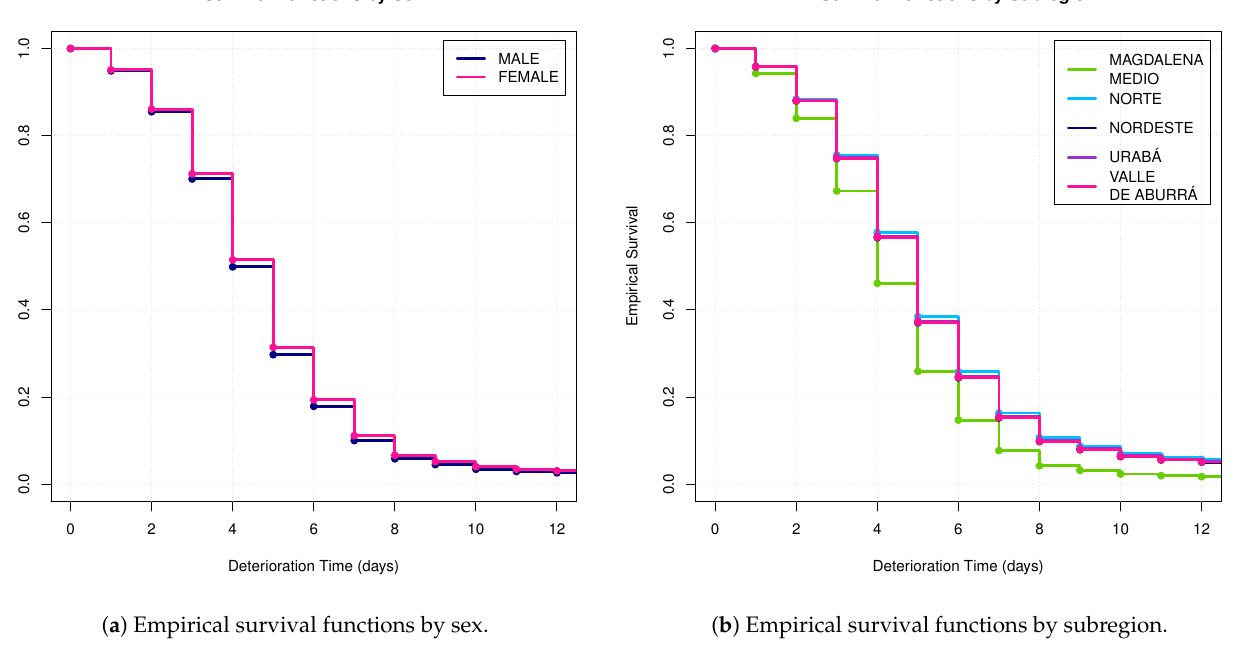
Figure 5. Survival functions for deterioration time according to the robust Cox regression model presented in Table 9. Table 9. Results of the robust Cox regression for clinical deterioration time analysis using the extended Wald test p -value <